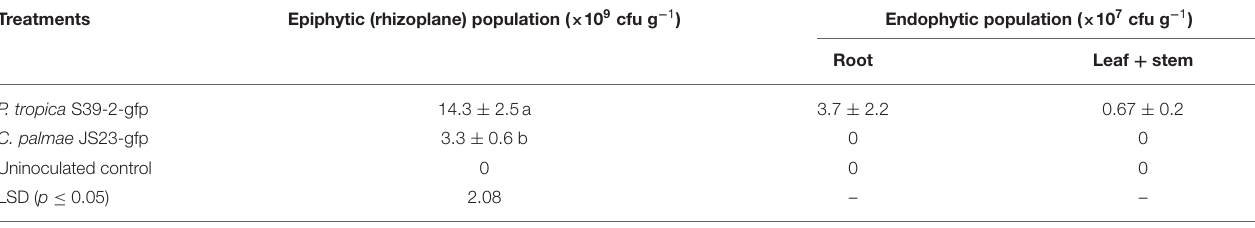
TABLE 2 | Colonization of eucalyptus tissues by gfp -tagged strains.